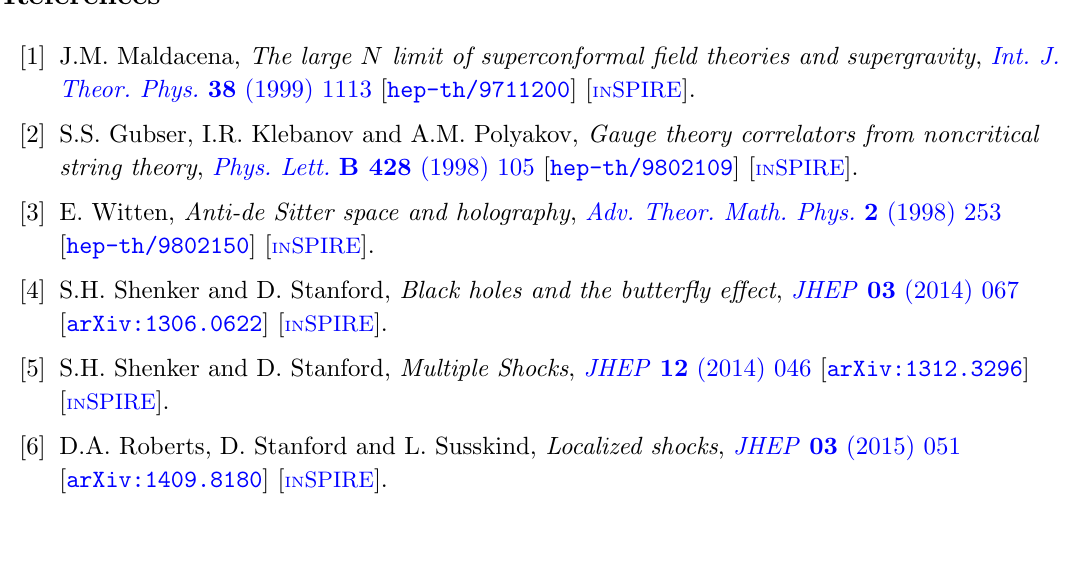
of the di(cid:11)usion matrix (green curve) and 3 T